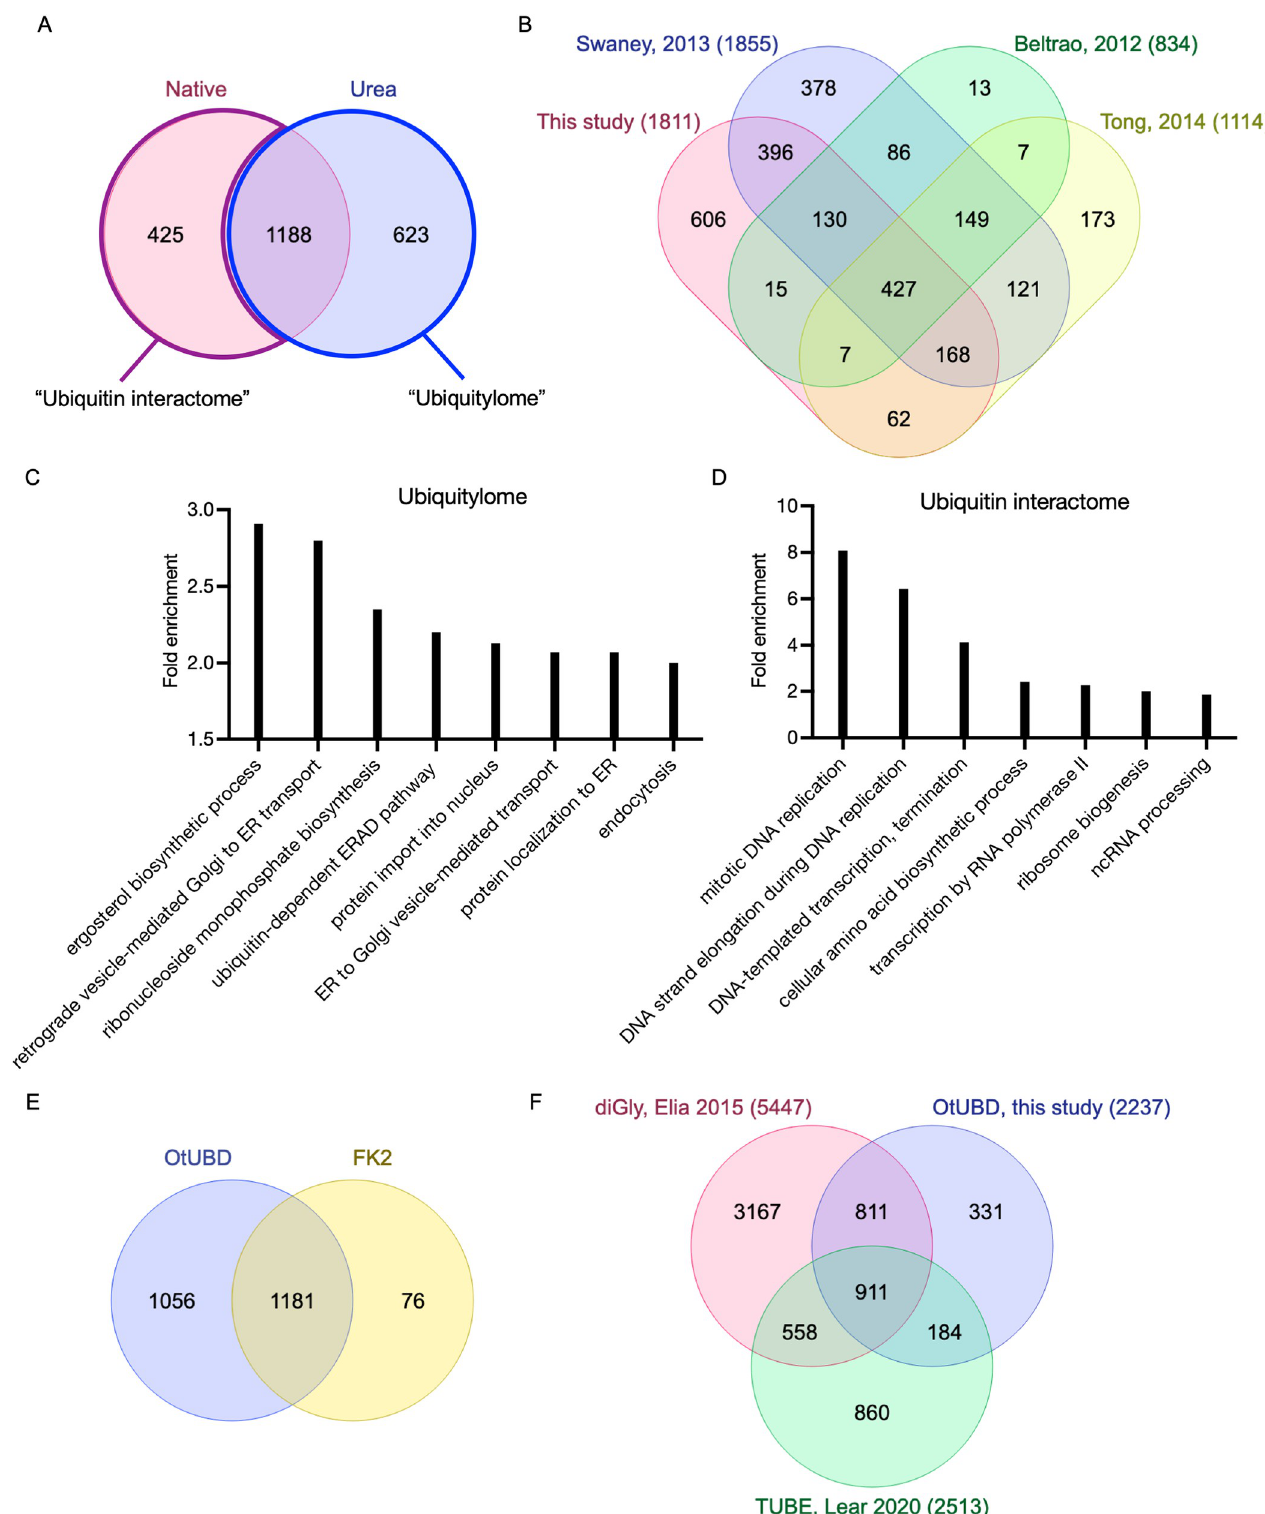
Fig 5. OtUBD pulldown-proteomics enables profiling of the ubiquitylome and ubiquitin interactome of yeast and human cells. (A) Venn diagram of yeast proteins identified by OtUBD pulldown-proteomics with the pulldowns performed following either nondenaturing or urea denaturing treatments.